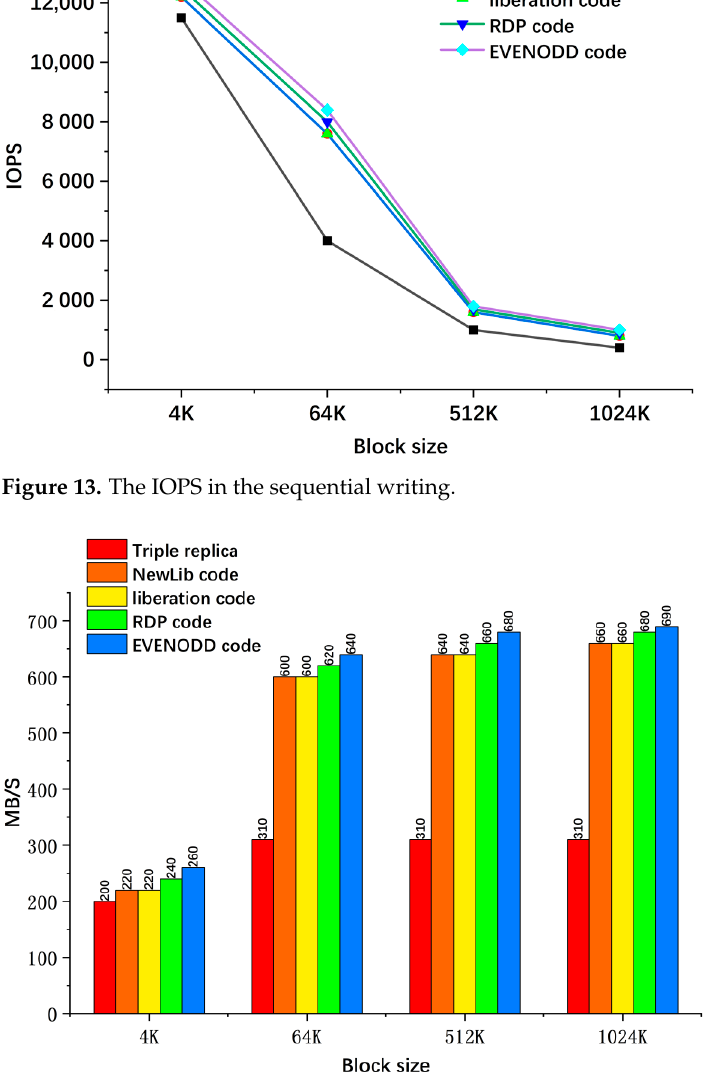
Figure 13. The IOPS in the sequential writing.